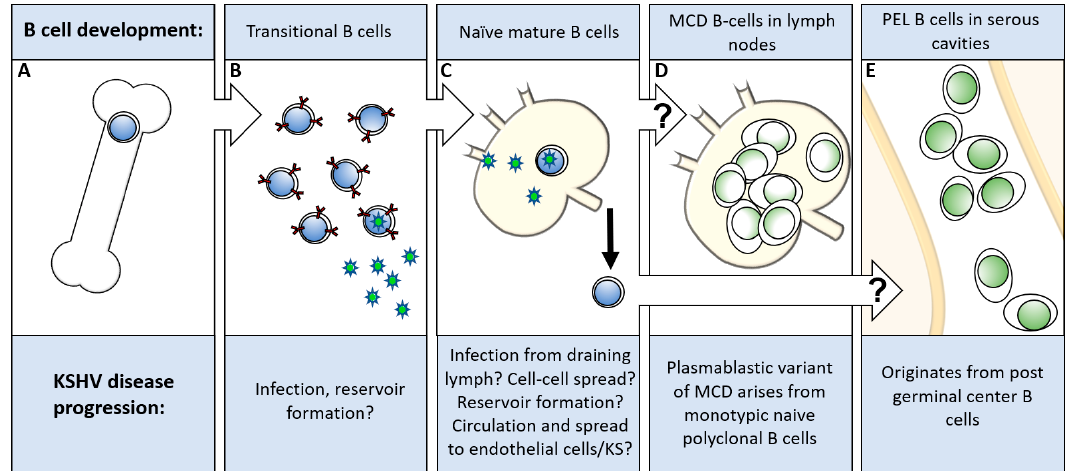
Figure 3. Model of KSHV B cell disorder development. ( A ) Stem cells develop into immature B cells in the bone marrow. ( B ) Transitional B cells expressing Immunoglobulin M-lambda light chain can be found in the bone marrow, peripheral blood or spleen. ( C ) Naïve / mature B cells migrate to the secondary lymphoid organs. ( D ) The development of MCD in the secondary lymphoid organs. ( E ) The development of PEL in body cavities such as the pleural space, pericardium, and peritoneum. PEL: primary effusion lymphoma; MCD: multicentric Castleman’s disease.